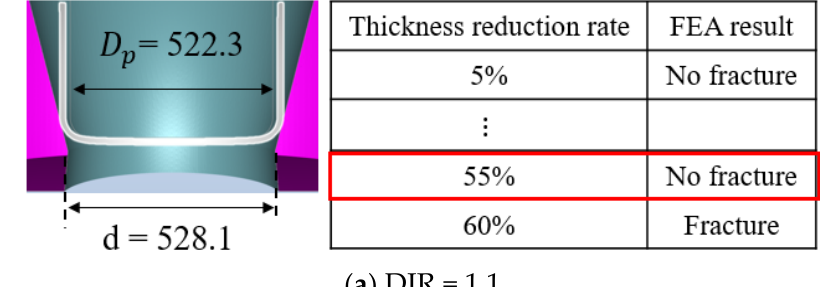
Figure 8. Comparison of the flow stress equation curve with the Hansel – Spittel equation.